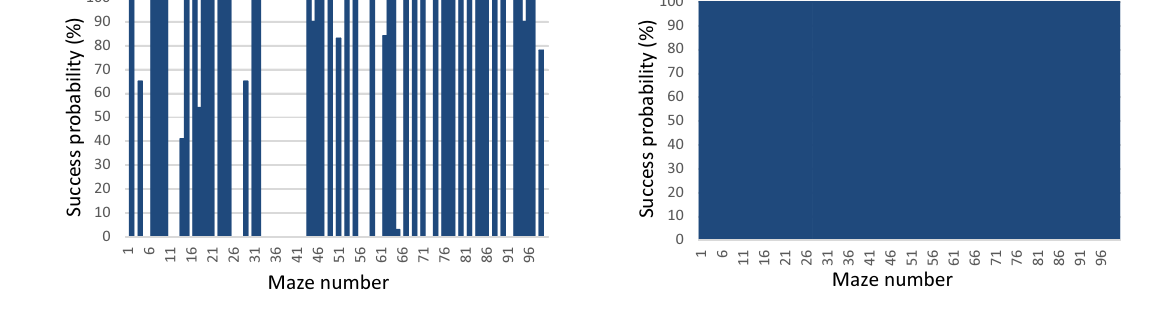
Figure 7: Q-learning case 1 Figure 8: Proposed method(Q-learning, gap10) case 1